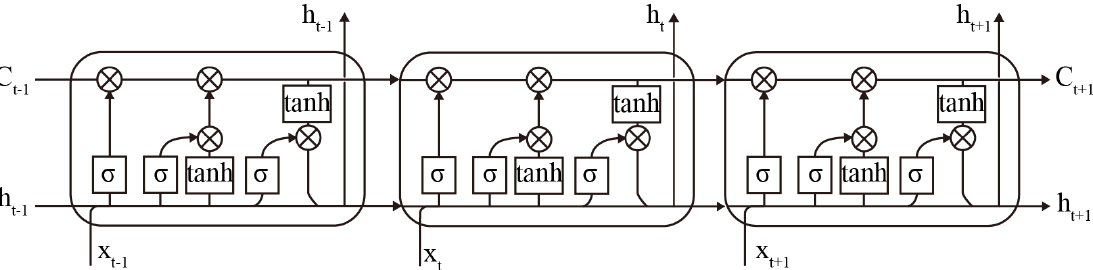
Figure 1. The structure of the LSTM network shows the cell states at three moments.